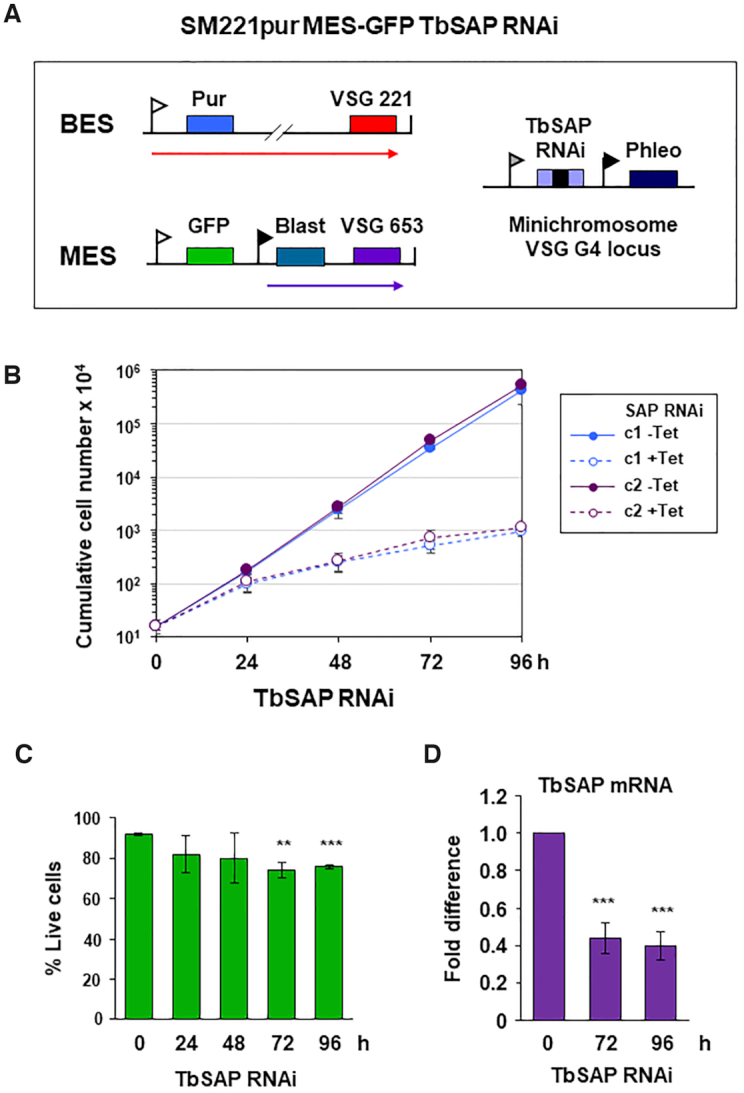
RNAi mediated depletion of TbSAP results in a reduction in growth rate with minimal lethality in bloodstream form T. brucei. (A) Schematic of the SM221pur MES-eGFP reporter cell line which expresses VSG221 from BES1, and which is selected for with a puromycin resistance gene (Pur). An eGFP gene was inserted immediately downstream of the endogenous MES VSG653 promoter (white flag). The construct was selected for using a downstream blasticidin gene (Blast) driven by an ectopic rDNA promoter (black flag). Transcription is indicated with arrows. A TbSAP stem-loop RNAi construct containing a tetracycline inducible T7 promoter (grey flag) was inserted into a locus containing the single copy minichromosomal VSGG4 gene (28). (B) Cumulative growth curve for two MES-eGFP TbSAP RNAi clones (c1 and c2) in the presence (+) or absence (−) of tetracycline (Tet) to induce TbSAP RNAi. Time is indicated in hours (h). The mean of three biological replicates is shown with standard deviation indicated with error bars. (C) Determination of live/ dead bloodstream form T. brucei cells stained with propidium iodide and analysed by flow cytometry after the induction of TbSAP RNAi for the time indicated. Data for clone c1 are shown with error bars representing the standard deviation from three biological replicates. Tests for significance (t-test) show slightly increased lethality after induction of TbSAP RNAi compared with time 0, with statistically significant results indicated with **P< 0.01 and ***P< 0.001. (D) Quantitation of TbSAP transcript with qPCR after induction of TbSAP RNAi for the time indicated in hours (h). Data from clone c1 are shown with error bars representing the standard deviation from three biological replicates. Statistical significance for the knock-down was determined using t-tests comparing with time 0 h (***P< 0.001).